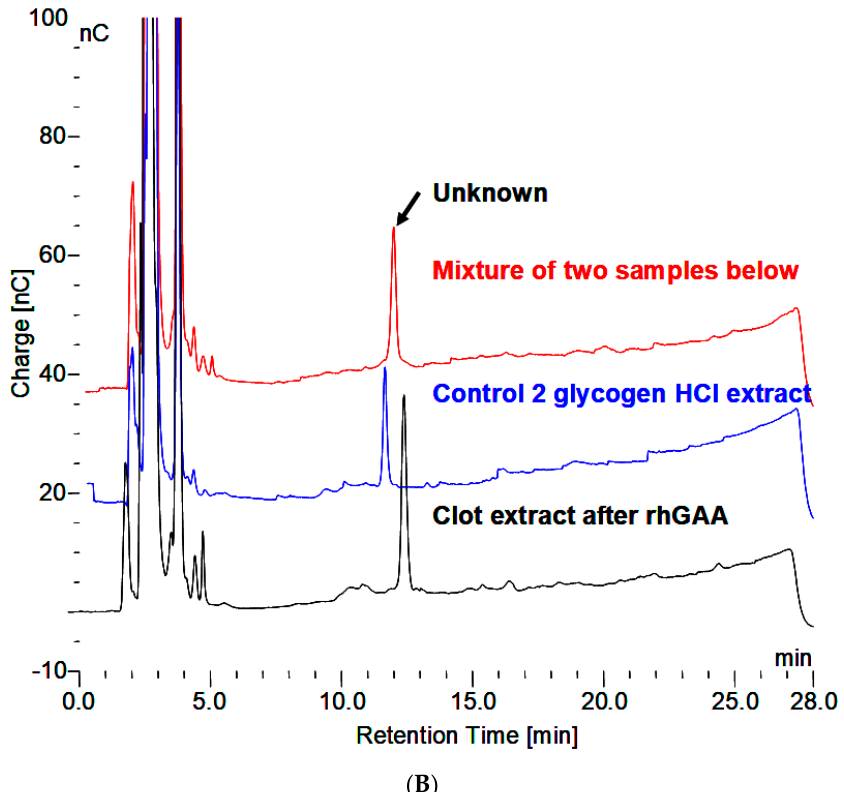
Figure 4. ( A ) Clot HCl extract before and after degradation with rhGAA demonstrating the Unknown is not degraded. ( B ) HCl extract of Control 2 glycogen, HCl extract of clot following rhGAA degradation, and a mixture of equal parts of both extracts demonstrating one symmetrical peak.